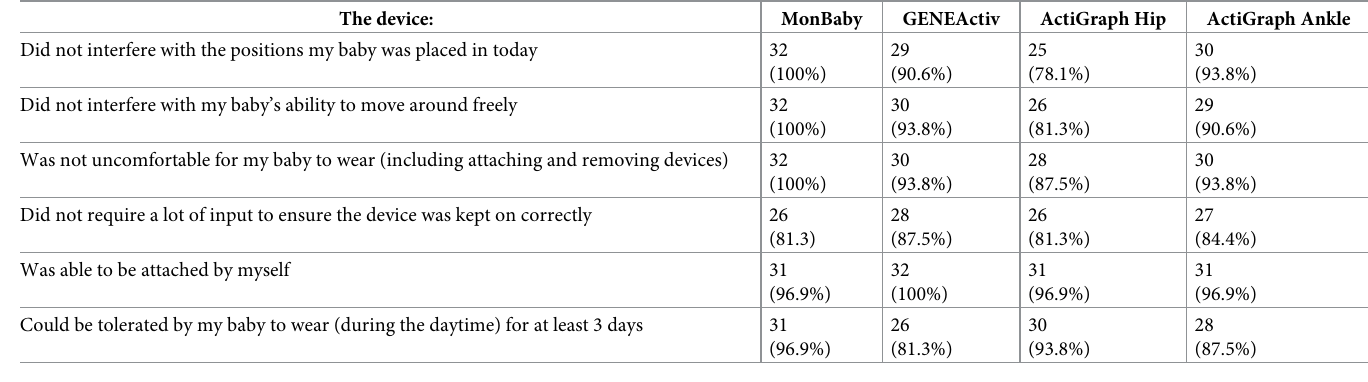
Table 5. Practicality questionnaire—Number of parents and percentage of agreement (N = 32). The